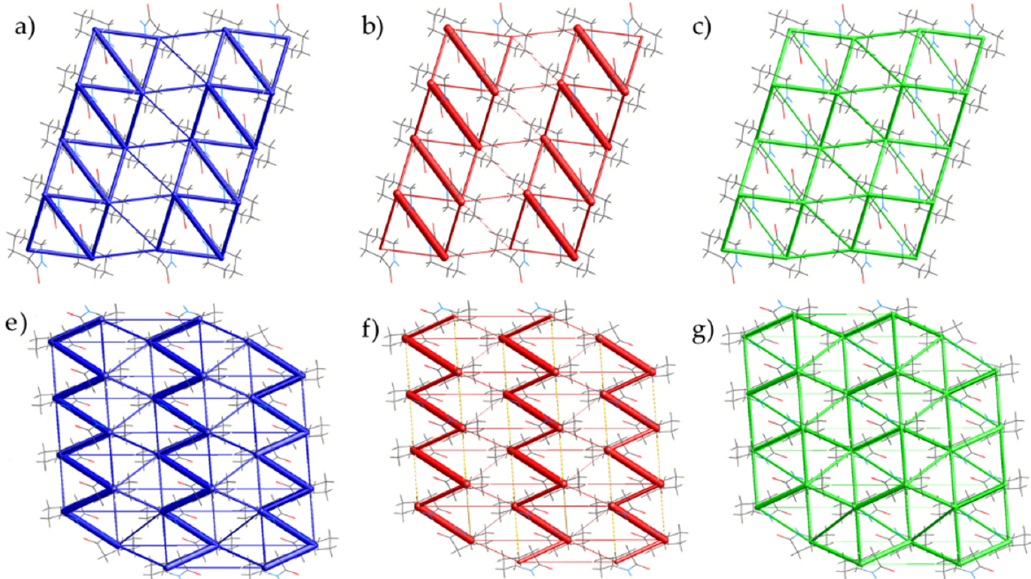
Figure 9. Energy frameworks for Forms II and III of caprolactam as calculated by CrystalExplorer [25]. Frameworks for the total energy (Form II, a ; Form III, e ), coulombic (Form II, b ; Form III, f ) and dispersive (Form II, c ; Form III, g ) contribution to the interactions. In each case, the view is along the hydrogen-bonded